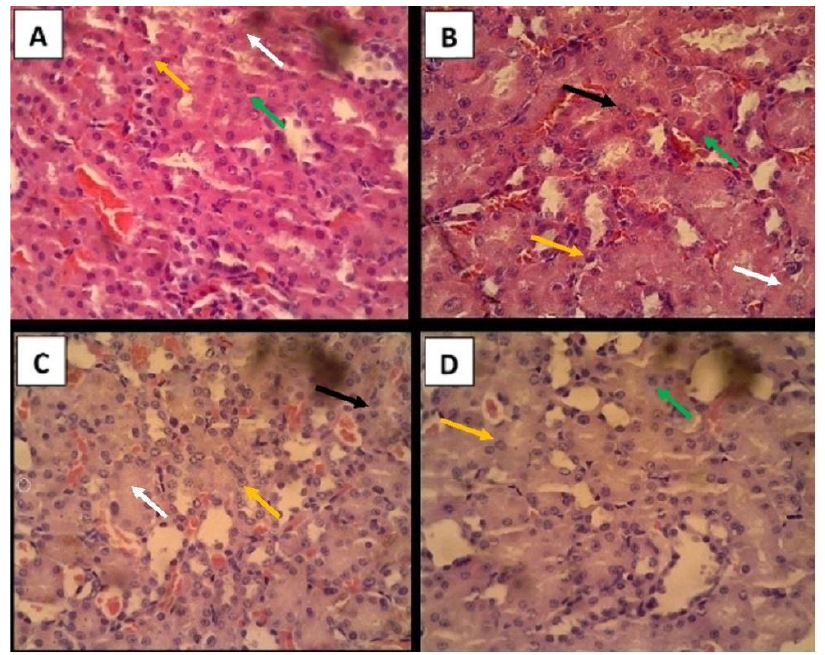
Figure 1. Histopathological features of kidney in formaldehyde-exposed rats at different treatment groups: (A) group I (formaldehyde only); (B) group II (formaldehyde and 100 mg/ kg BW meniran ); (C) Group III (formaldehyde and 200 mg/ kg BW meniran ); (D) Group IV (formaldehyde and 300 mg/ kg BW meniran ). Yellow arrow shows albuminous degeneration, black arrow shows hydropic degeneration, green arrow shows fat degeneration, and white arrow shows necrotic /apoptotic cells. Table 1. The mean of cell damage number ( D ) of kidney in the various groups Group